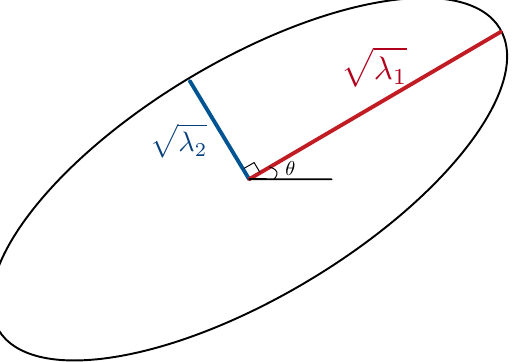
Figure 3. Error ellipse representing the covariance